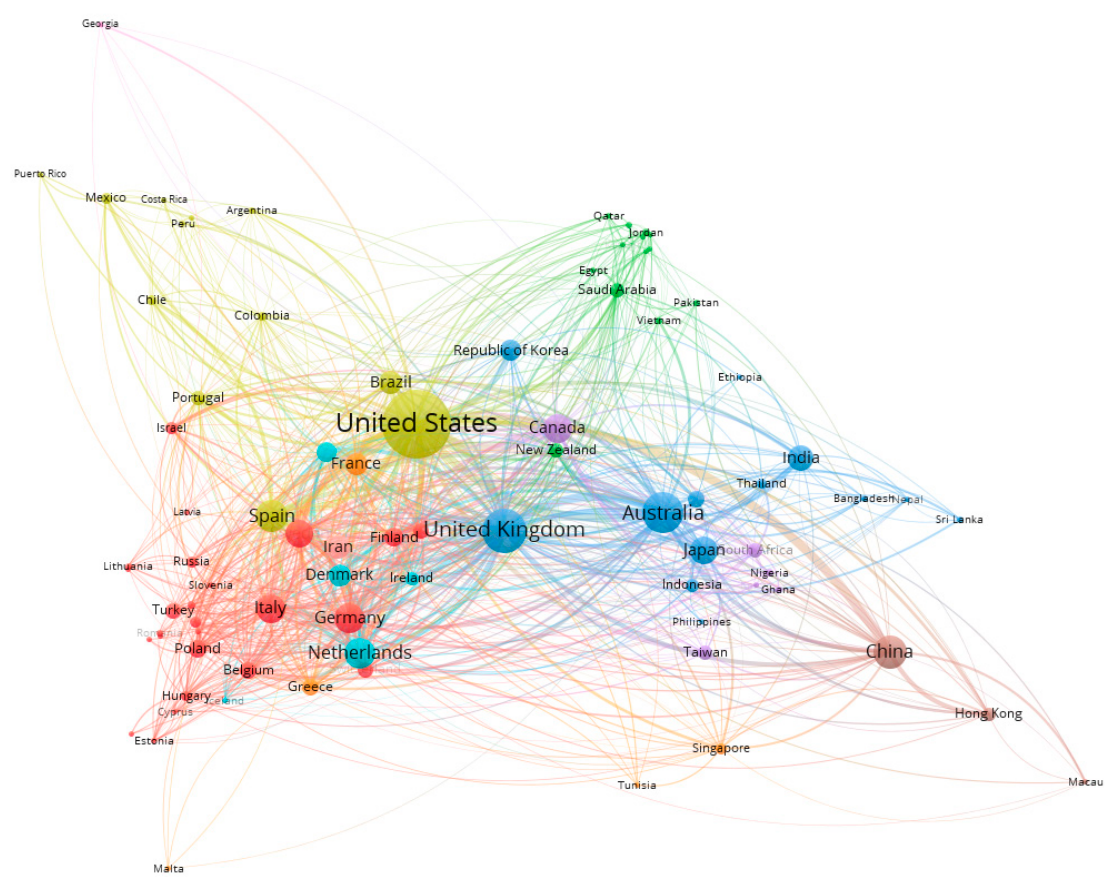
Figure 1. Distribution and co-authorship of countries/regions. Table 2. Top 10 countries/regions publishing lifestyle research, 2016–2020. Rank